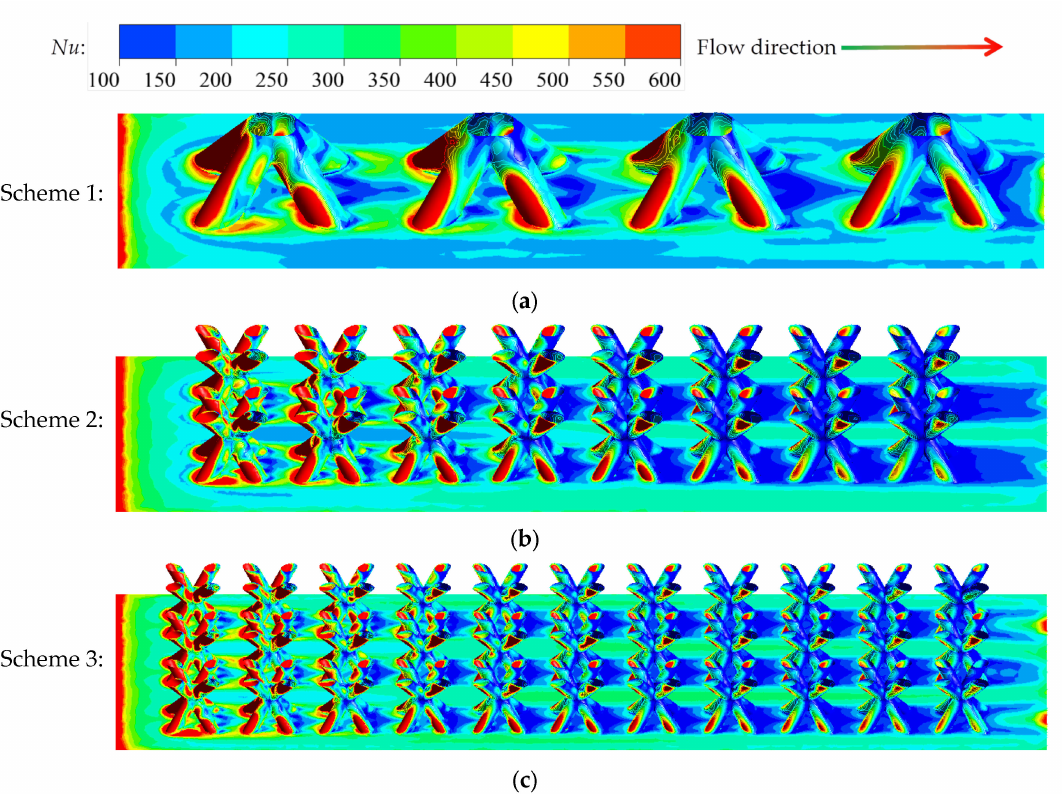
Figure 8. Heat transfer distributions of X-shaped truss array channels at different layout schemes ( Re = 30,000): ( a ) Scheme 1; ( b ) Scheme 2; ( c ) Scheme